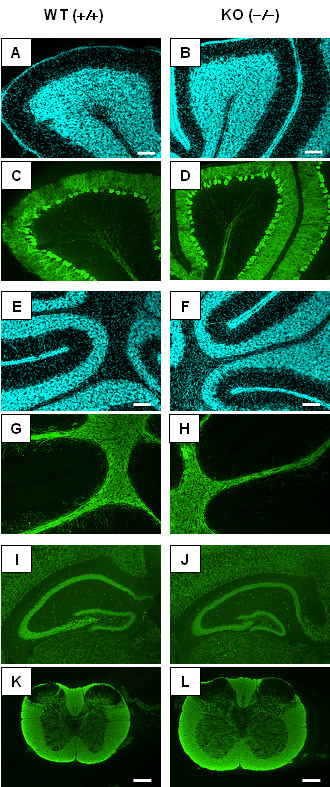
Normal neurodevelopment in the CNS of ADAM22-deficient mice. Sagittal sections of the cerebellum from wild-type mice (A, C, E, G) and homozygous mutants (B, D, F, H) at postnatal day 13 were stained for calbindin (C and D; green) or MBP (G and H; green), and were counterstained with DAPI (A, B, E, F; blue). Significant abnormalities were not observed in the homozygotes. Hippocampal neurons were stained by anti-Neu N antibody (I and J). Spinal myelin was analysed by MBP staining (K and L). These analyses showed no obvious differences between homozygotes (J, L) and wild-type littermates (I, K). Bar: (A, B, E, F) 100 μm, (K, L) 250 μm.